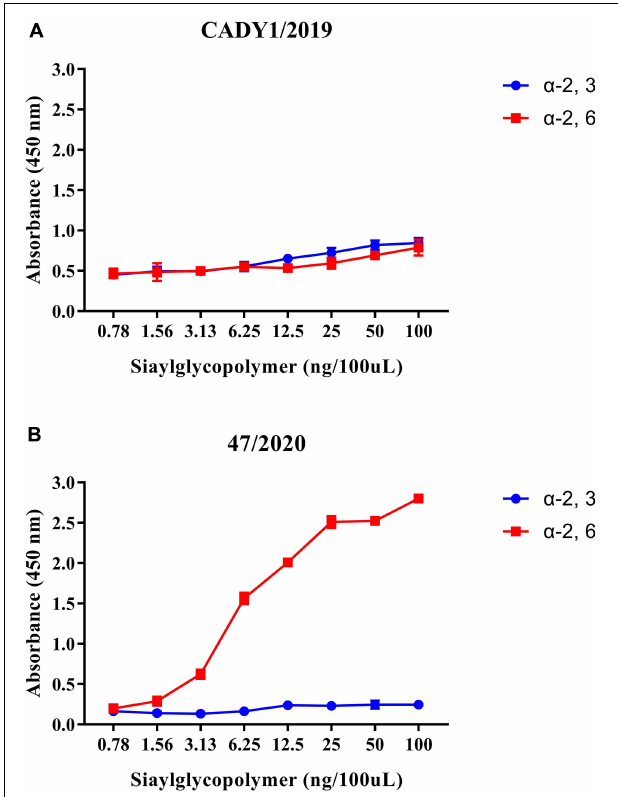
FIGURE 3 | Receptor-binding ability of CADY1/2019 (A) and 47/2020 (B) . The binding ability of the viruses to two different biotinylated glycans ( α -2, 3-siaylglycopolymer, colored in blue, α -2, 6-siaylglycopolymer, colored in red) were detected. The antibody used for the receptor-binding ability of CADY1/2019 was guinea pig sera anti CADY1/2019. The antibody used for the receptor-binding ability of 47/2020 was a monoclonal antibody against H3 subtype AIV that reacts with 47/2020. Every experiment was conducted twice, expressed as mean ± SD.